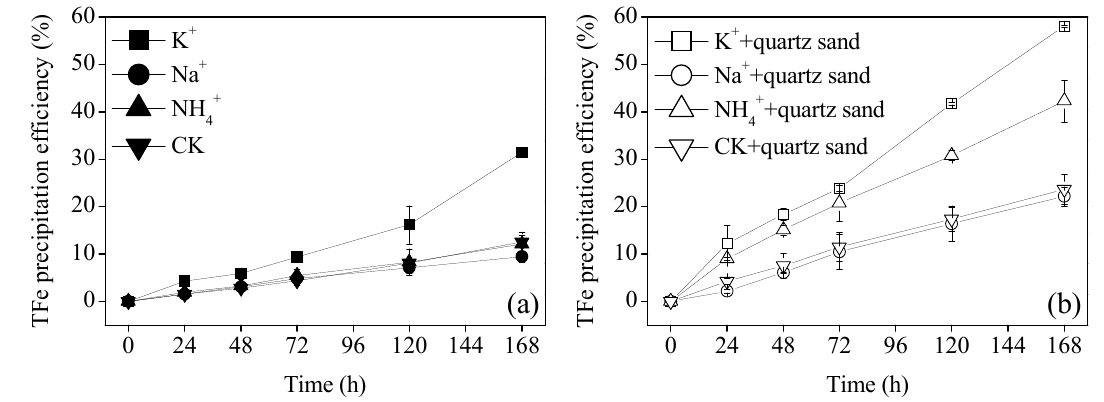
Figure 3. Change of TFe concentration ( a ) without and ( b ) with quartz sand in simulated acid mine drainage (AMD) system.